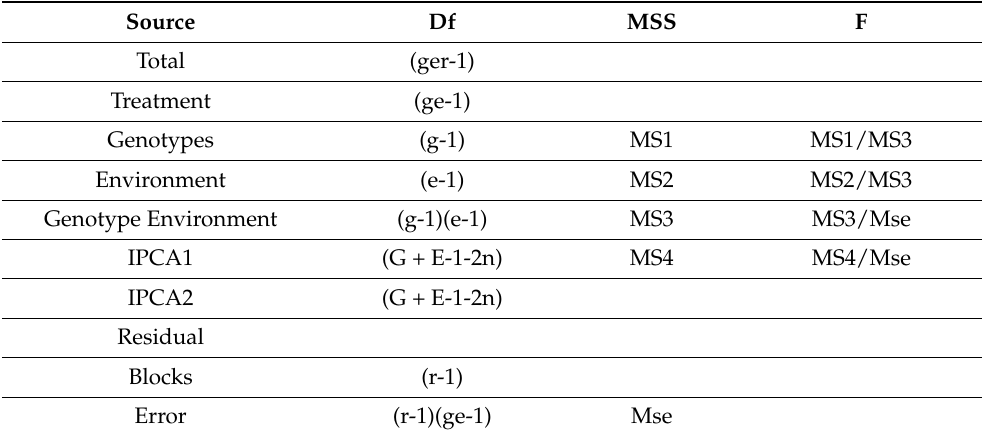
Table 3. Data collected from separate trials were analyzed as combined over the environments using the following ANOVA outline:.